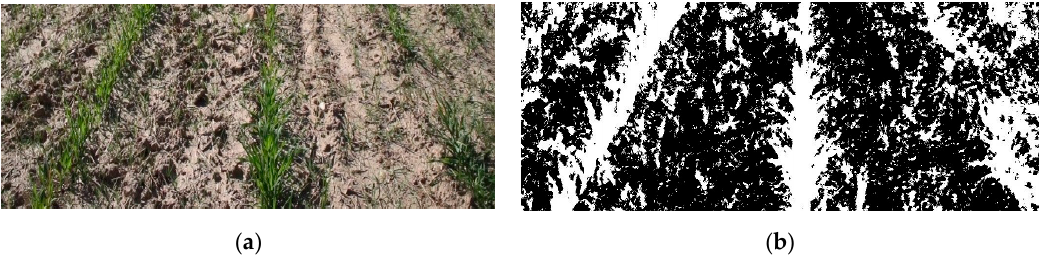
Figure 6. ( a ) Original image with marked weed presence. ( b ) Segmented image.